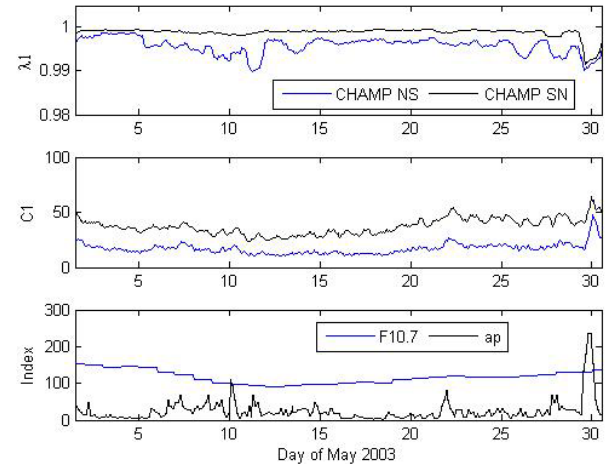
Fig. 3. Variations with UT of the λ 1 parameter (upper panel) and the c 1 projection coefficient in 10 12 kgm − 3 (middle panel) during May 2003, for day time (SN; black line) and night time (NS; blue line) orbit segments. Note that the definition of c 1 (see Eq. A1 and text for further details) implies that its value is typically ten times larger than the typical density value along the orbit segment. The variations of the Solar F10.7 (blue line) and geomagnetic a p indices (black line) during May 2003 are displayed in the lower